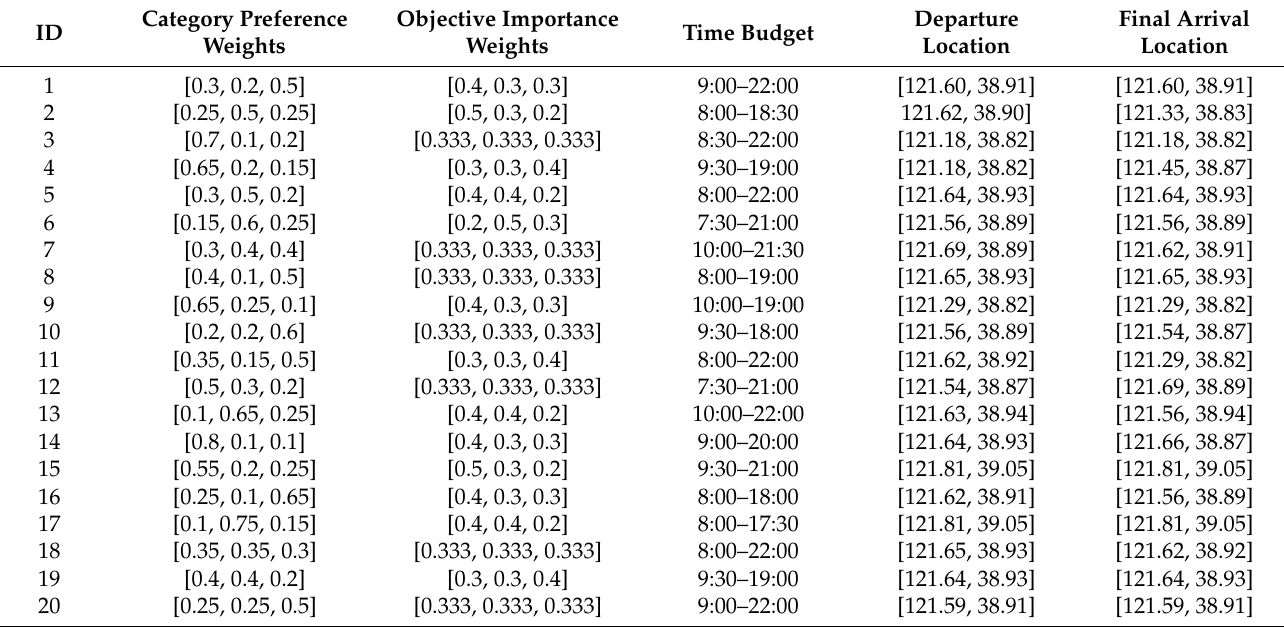
Table A2. Personalized parameters of 20